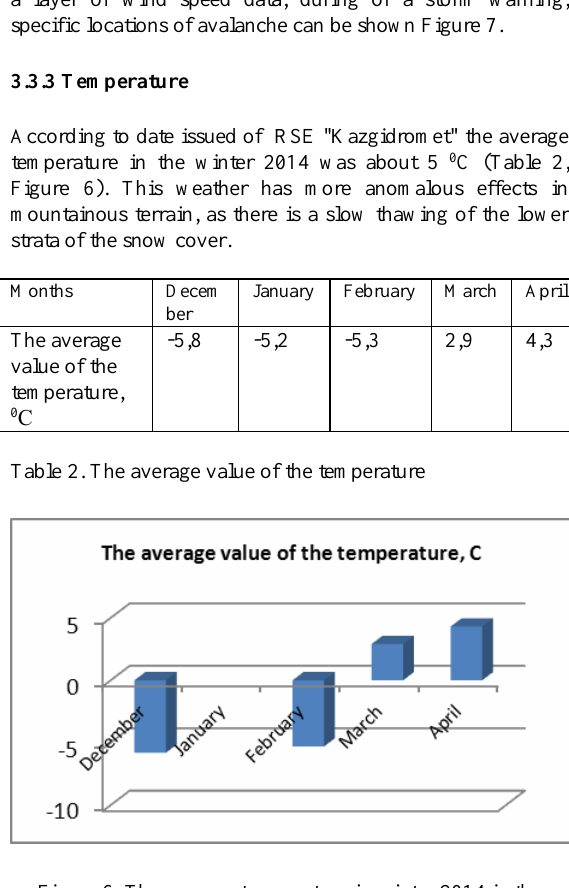
Figure 6. The average temperature in winter 2014 in the alpine resort area